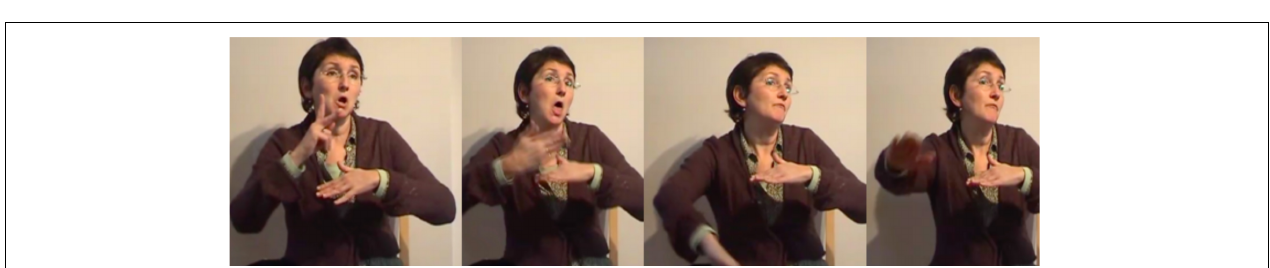
FIGURE 16 | Classifier construction that traces the shape of the cliff.